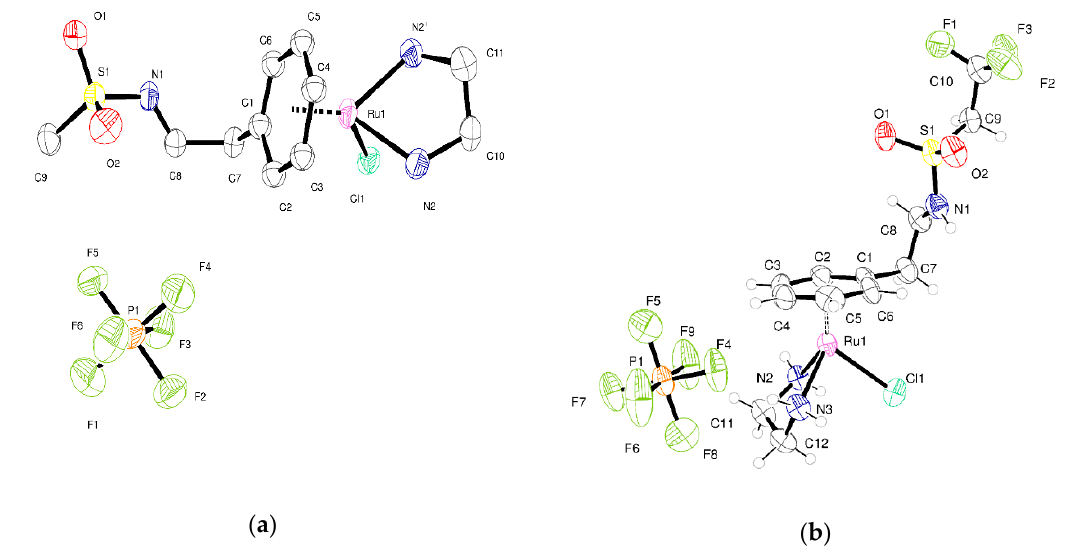
Figure 3. ( a ) ORTEP plot of complete asymmetric unit of 1 with atoms shown as 50% displacement parameters; ( b ) Asymmetric unit of 2 at 150 K with atoms drawn as 50% displacement ellipsoids.